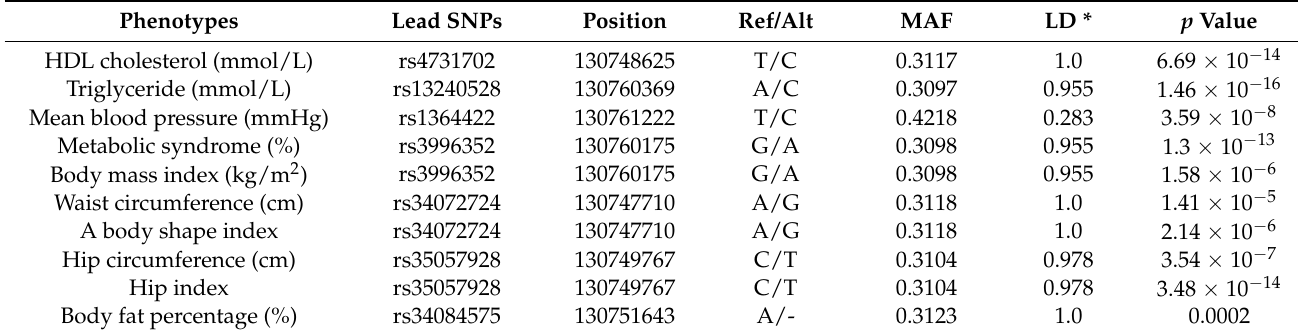
Table 1. Lead single nucleotide polymorphisms (SNPs) for various phenotypes at the KLF14 gene